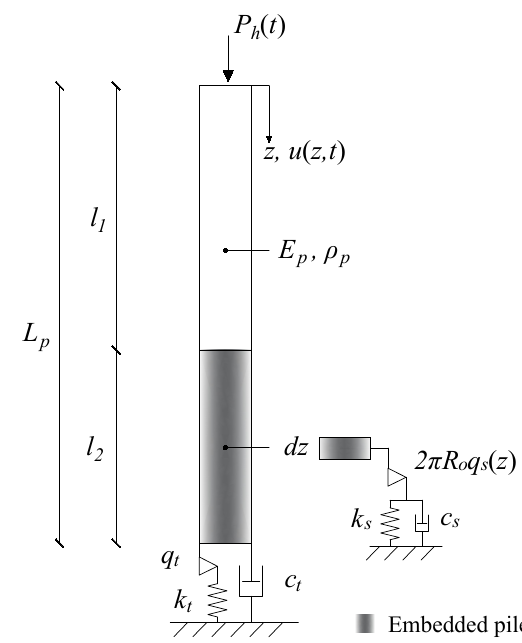
Figure 1. The one-dimensional pile driving model, with the pile described as a